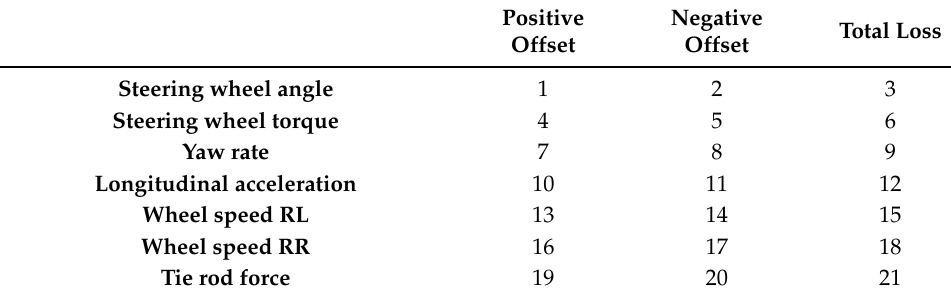
Table A3. Fault code for sensor fault based on machine learning.